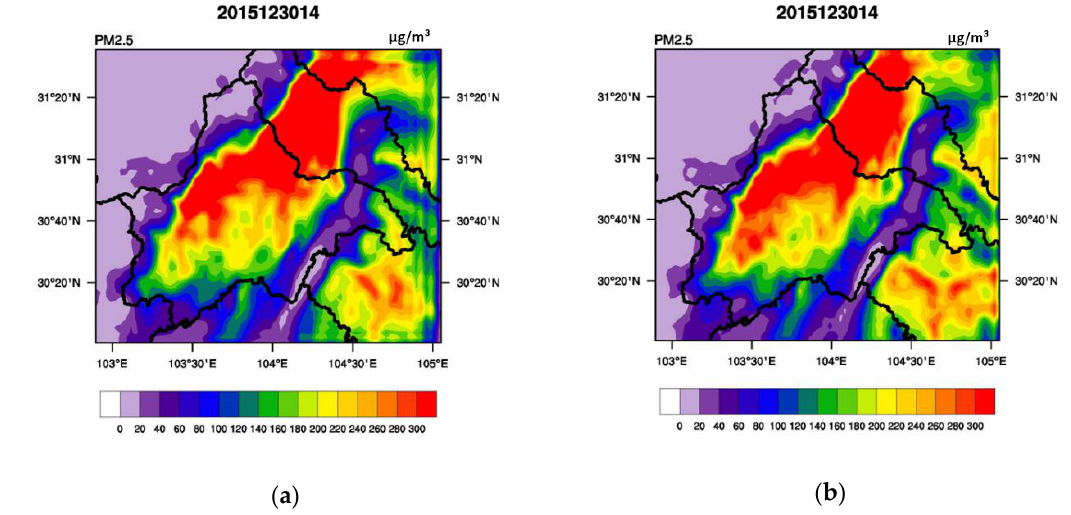
Figure 11. The PM 2.5 concentration map simulated using 1980 ( a ) and 2015 ( b ) land-use data (local time at 14:00 on December 30, 2015).